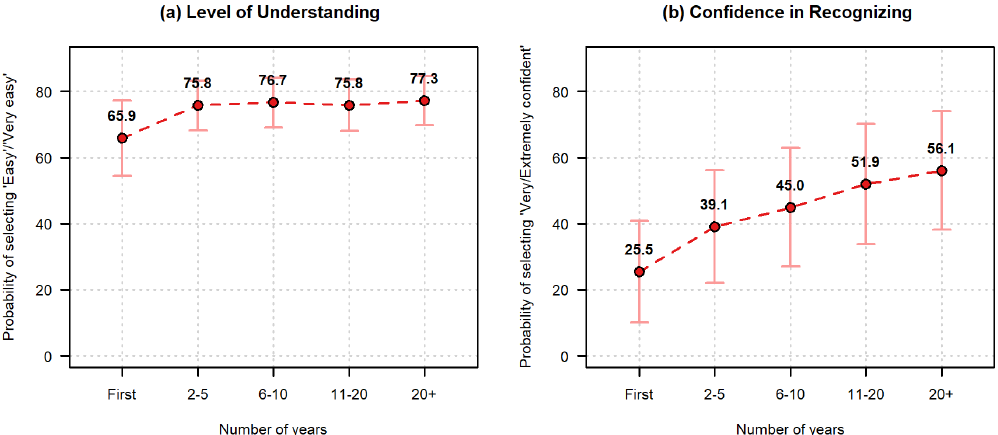
Figure 5. Estimated marginal probabilities for selecting easy or very easy for understandability of the statement (a) and selecting very or extremely for confidence in recognizing the key phrase in the field (b) as a function of years of backcountry experience in the jargon model. Error bars represent 95% confidence intervals for probabilities calculated from the subsample for the particular parameter level. Variable levels for calculations of estimated marginal probabilities: attention to TTA statements – considerable, days spent in the backcountry each winter – 1–20d, avalanche awareness training – introductory, bulletin user type – type D, and statement treatment – less